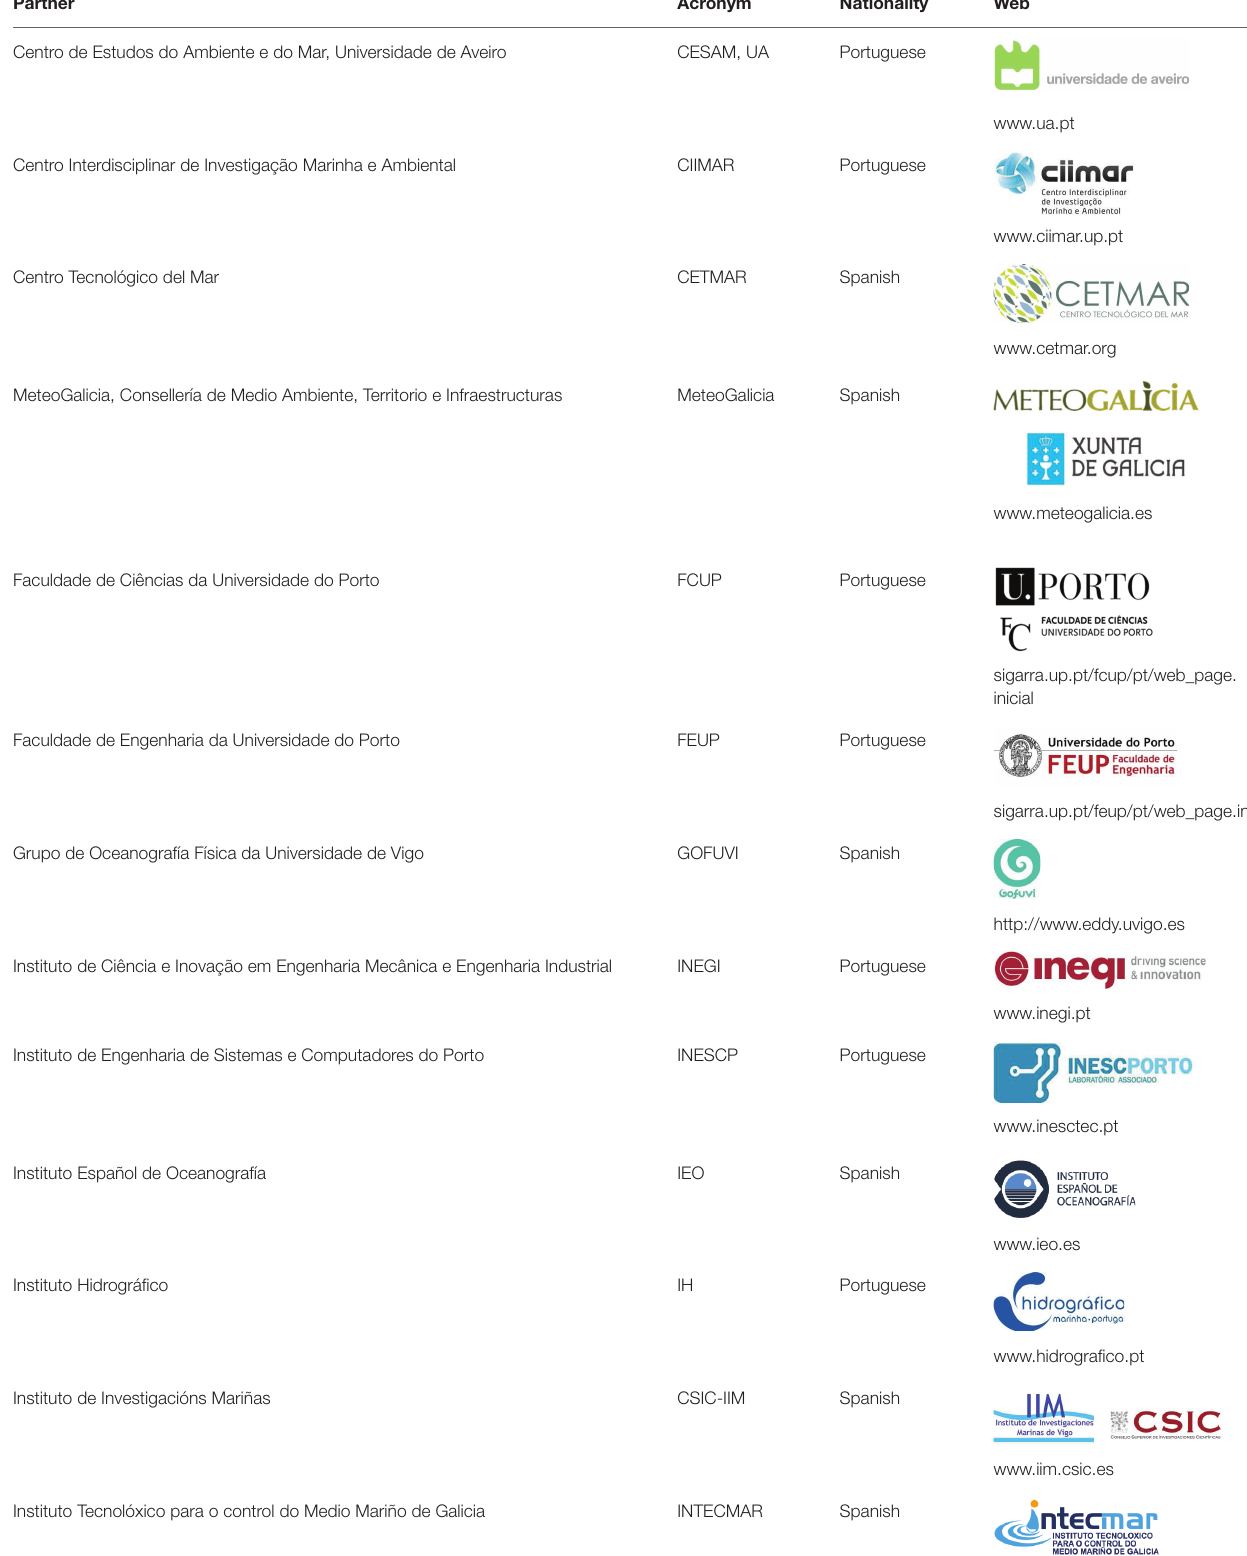
TABLE 1 | RAIA observatory